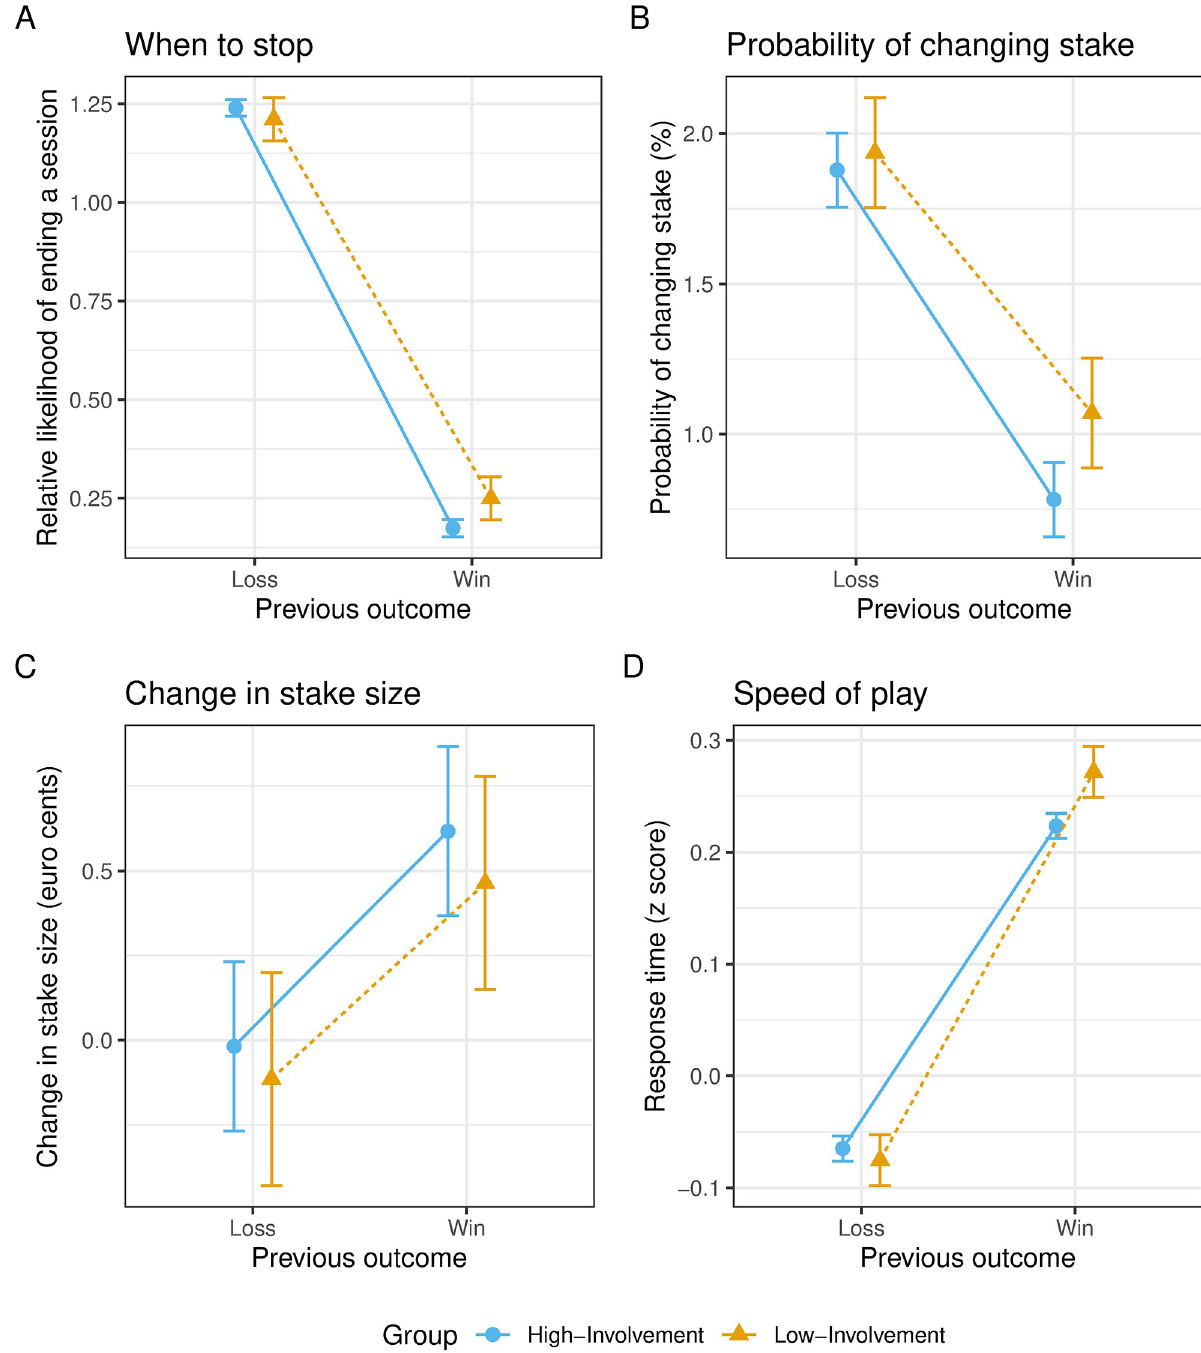
Fig 3. Behavioral expressions of within-session chasing. (A) when to stop, (B) probability of changing stake, (C) change in stake size, and (D) speed of play. For panel (A), relative likelihoods are the conditional probabilities of stopping after a loss and after a win, normalized per player by the overall probability to stop, e.g. p( stop | loss )/p( stop − overall ) and p( stop | win )/p( stop − overall ). Error bars stand for 95% within-subject confidence intervals.